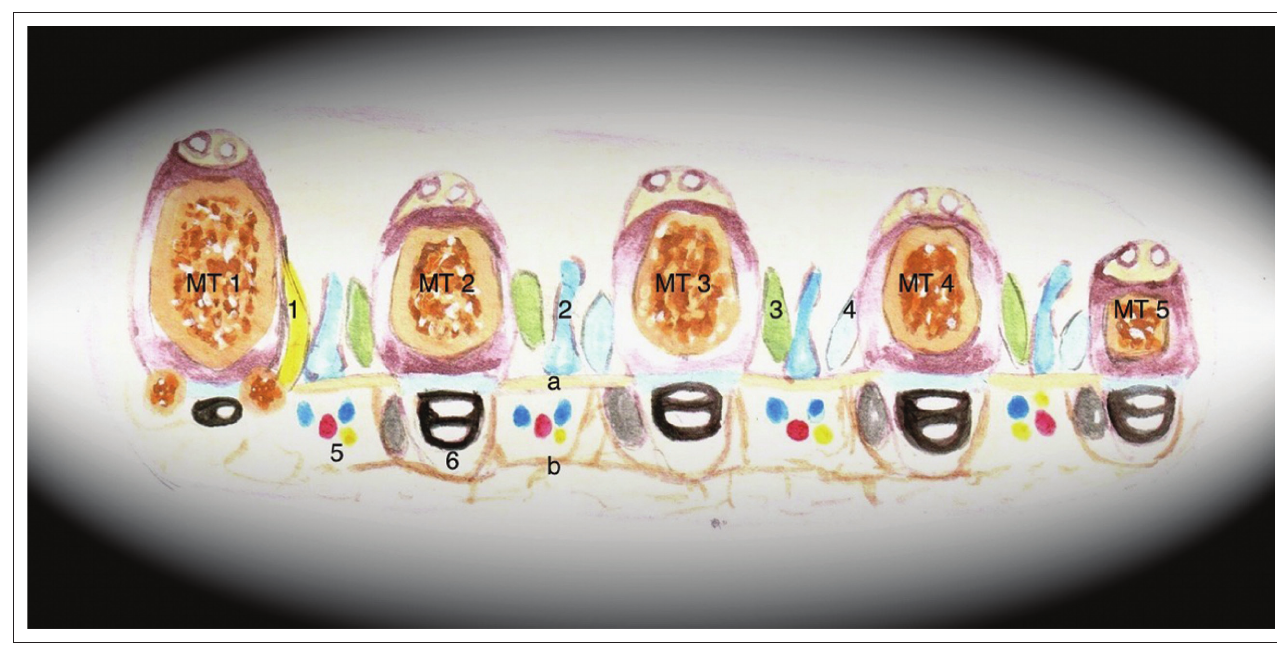
FIGURE 3: Schematic diagram of forefoot anatomy in the short axis view.